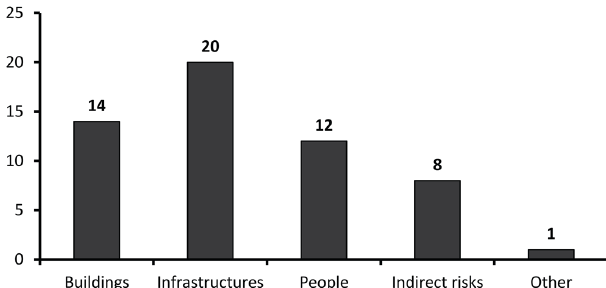
Fig. 3. Number of landslides that are endangering buildings, trans- portation infrastructures and people, and creating indirect risks or even other issues. The total number is over 23, because conse- quences of a landslide can affect more than a single